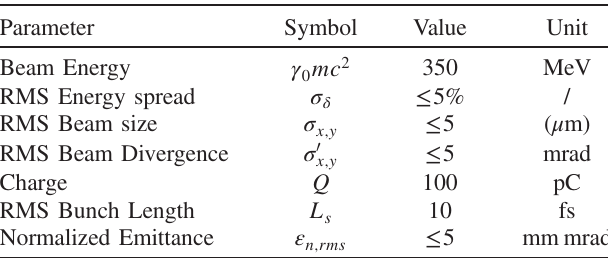
TABLE II. Electron beam parameters for beam